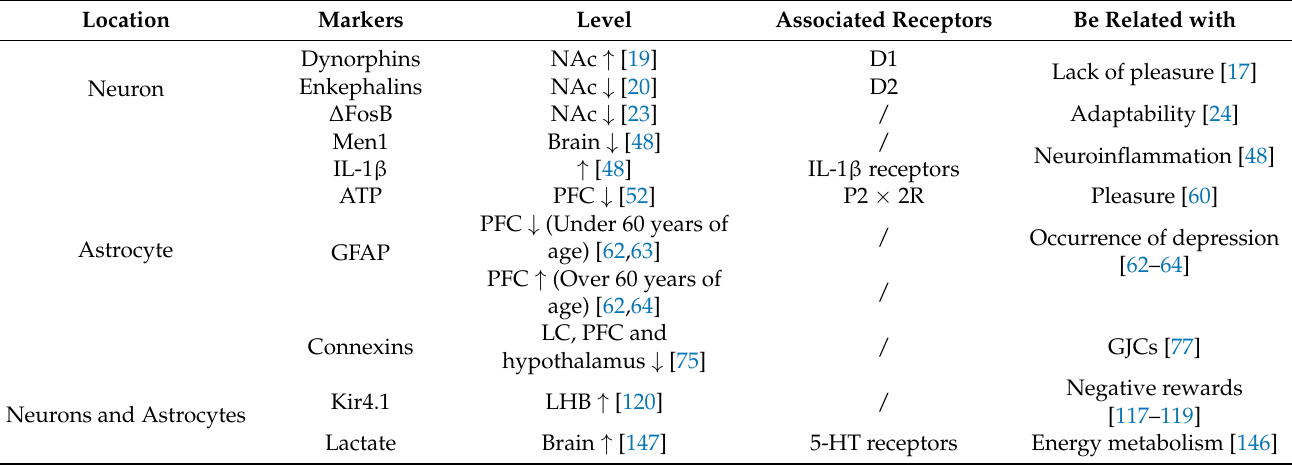
Table 1. Marker substances in depression linked to astrocytes and neurons. NAc: Nucleus accumbens; D1: Dopamine receptor 1; D2: Dopamine receptor 2; Men1: Multiple endocrine tumor type 1; IL-1 β : Interleukin-1 β ; ATP: Adenosine triphosphate; PFC: Prefrontal cortex; P2 × 2R: P2 × 2 receptor; GFAP: Glial fibrillary acidic protein; LC: Locus coeruleus; LHB: Lateral habenula;